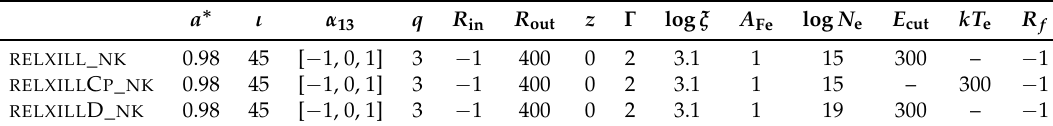
Table 2. Model parameters used for Figure 2. R in = − 1 corresponds to setting R in to the ISCO radius and R f = − 1 corresponds to only including the reflected component of the spectrum.